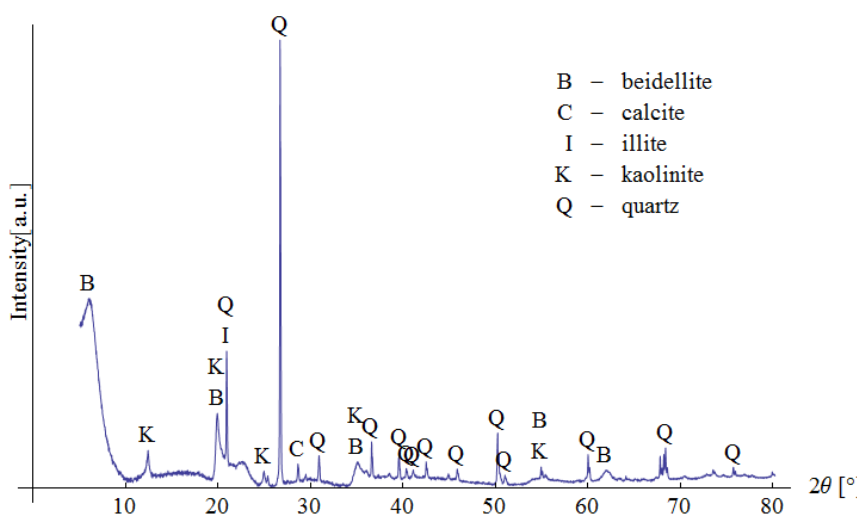
Figure 3. XRD analysis of the tested material.